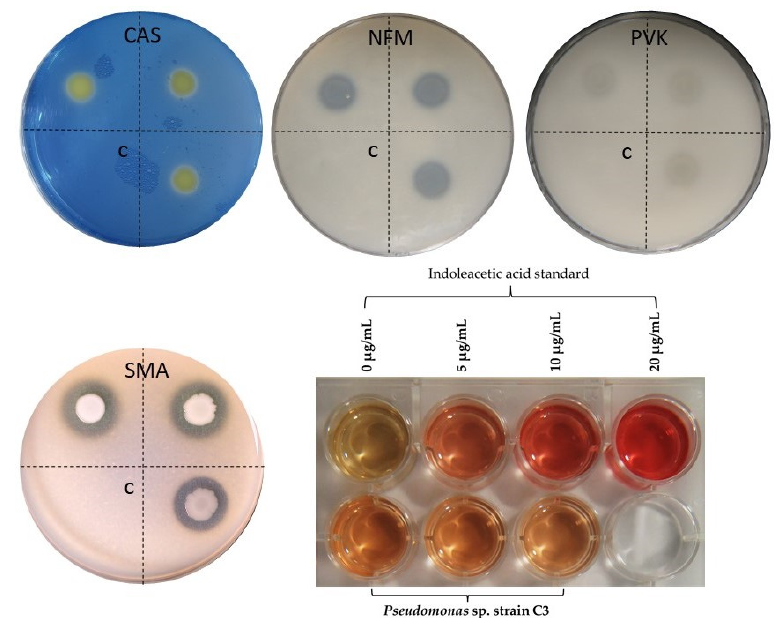
Figure 6. In vitro assays showing PGP traits and proteolytic activity of Pseudomonas sp. strain C3. Siderophore production (CAS). Nitrogen fixing (NFM). Phosphate solubilization (PVK). Protease activity (SMA) and IAA quantification assay (Salkowski test). The letter “C” on the Petri dishes indicates the negative control corresponding to the culture medium without bacteria.